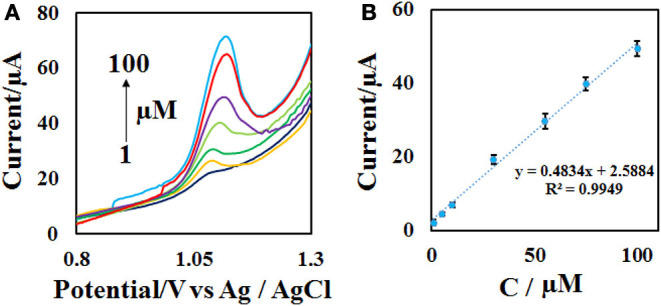
(A) DPVs of the CdO/Fe3O4/CPE in the presence of 1–100 μM ACV in 0.1 M phosphate buffer (pH = 4) and the scan rate of 50 mV s−1 and (B) the calibration curve.